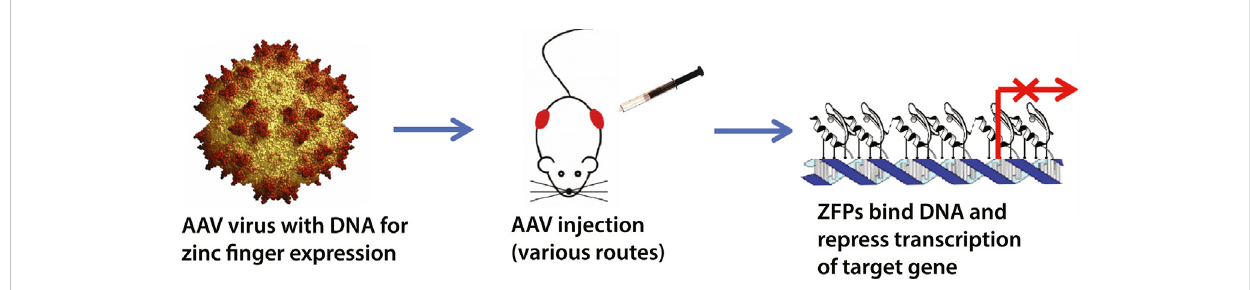
FIGURE 1 Schematicoverview of the zinc fi nger transcription factor (ZF-TF) platform. We have previously designed zinc fi ngers to selectively target expanded CAG-repeats in Huntington ’ s disease (Garriga-Canut et al., 2012; Agustin-Pavon et al., 2016). The ZF-TFs are delivered as DNA in adeno-associated viruses (AAVs) and can be delivered by injection via various routes, including intrathecal and intravenous. The zinc fi ngers are expressed inside cells and bind their DNA targets to repress transcription via KRAB repressor domains fused to the zinc fi